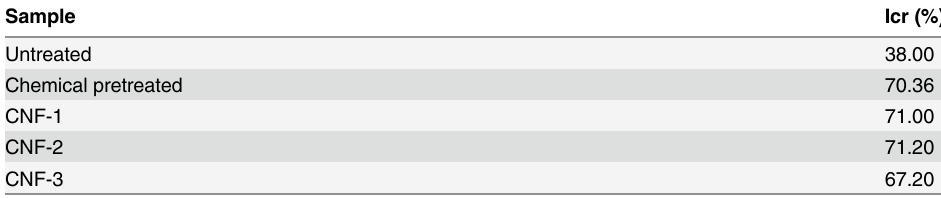
Table 3. Crystallinity index (Icr) of coconut palm petiole fibers at different stage of treatment.